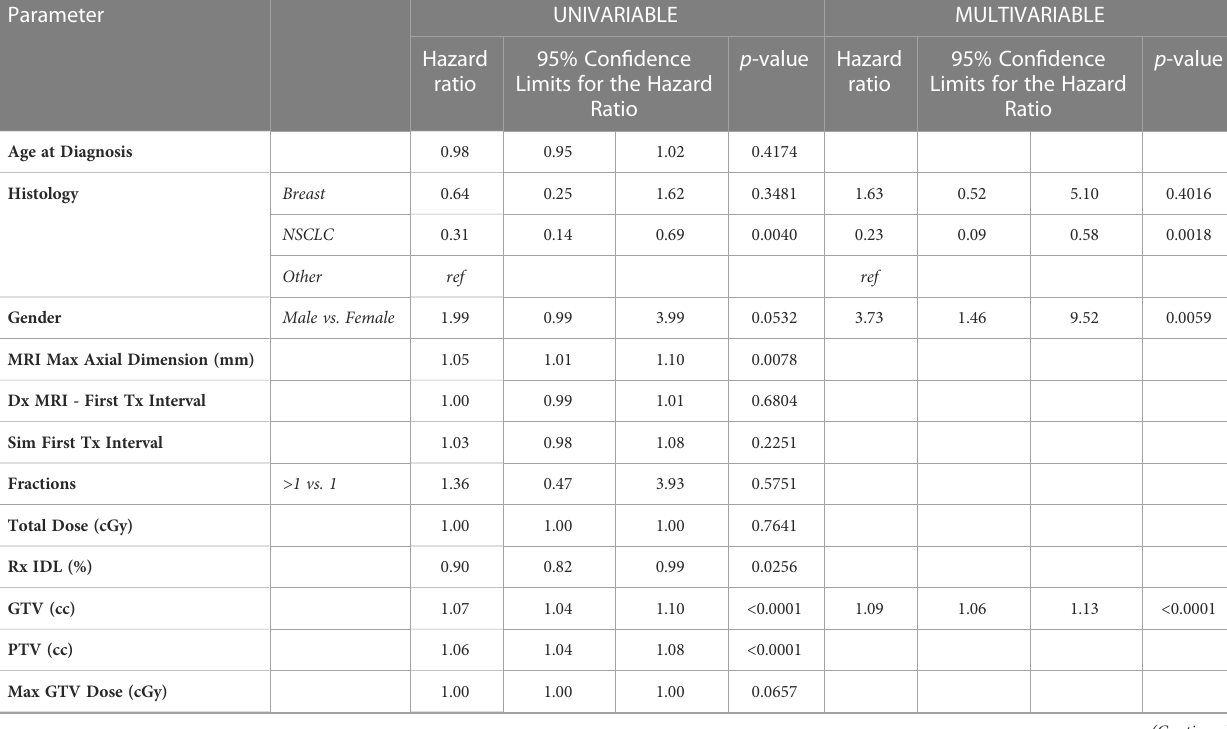
TABLE 3 Univariable and multivariable analyses for time to local